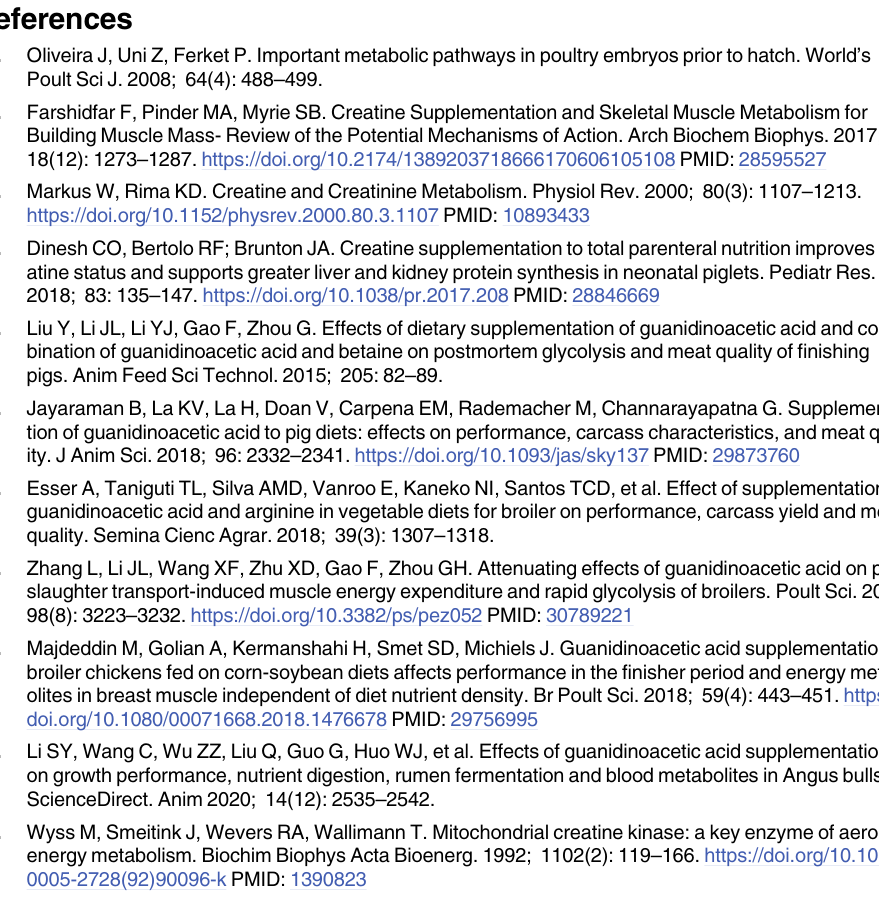
S9 Table. The mRNA expression levels of SLC6A6(A) & SLC6A8(B) in lambs small intestinal segment